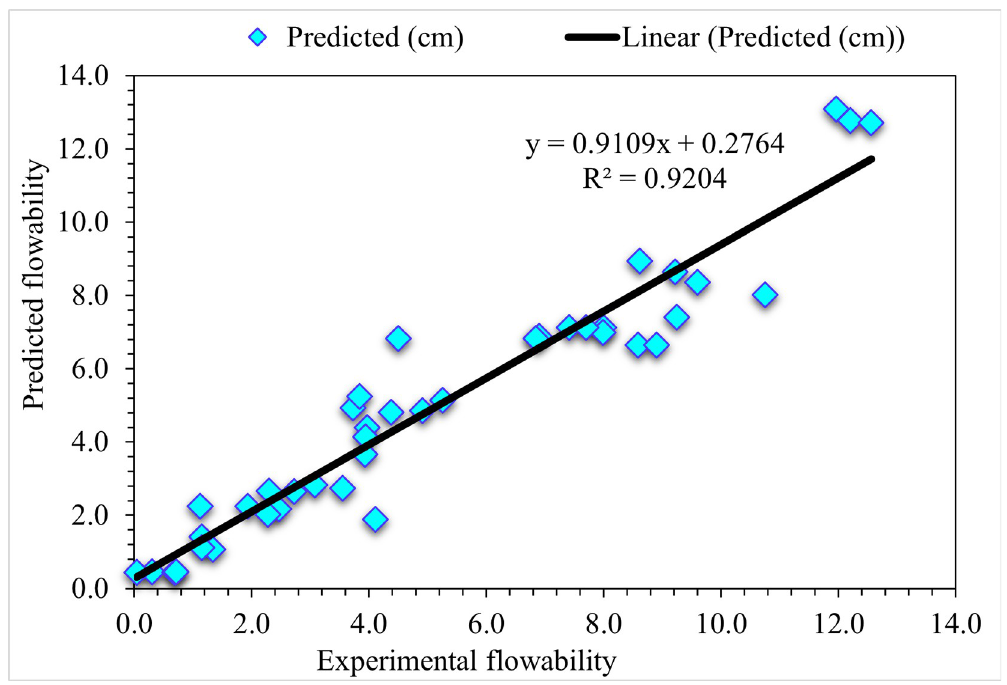
Fig 8. GB predicted and experimental values—UHPC flowability.